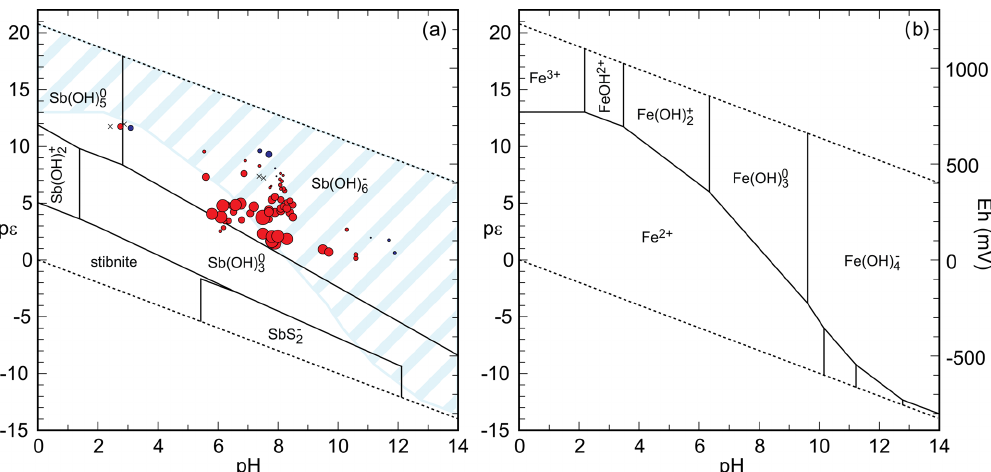
Figure 7. (a) pH– p(cid:15) diagram for the system Sb-O-S-H with the predominance field of aqueous species and the stability field of stibnite. Data from Filella and May (2003). In this diagram, log a((cid:54)Sb) = − 5, log a((cid:54)S) = − 4. The symbols show the saturation of mine drainage solutions with respect to chapmanite and are scaled to the magnitude of the saturation indices. Red circles – supersaturated; blue circles – undersaturated; crosses – solutions so close to saturation that the corresponding circles would be invisible. The light blue hatched area is the predominance field of Fe(III) species (log a((cid:54) Fe ) = − 5), with the corresponding full pH– p(cid:15) diagram shown in panel (b)